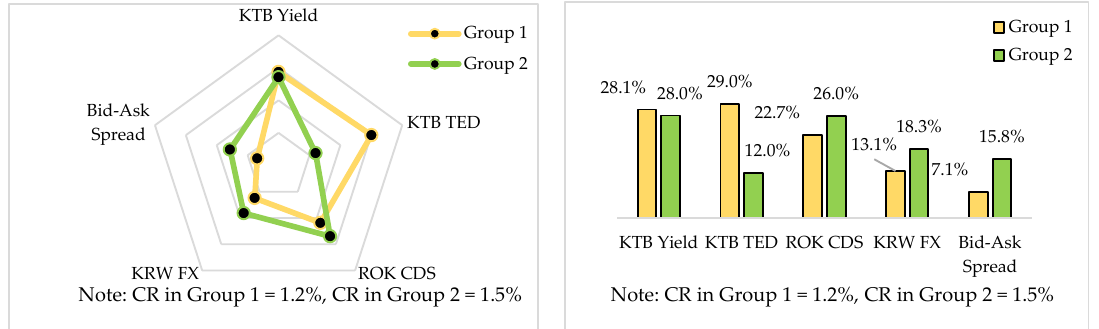
Figure 9. Local weights for domestic factors between group 1 and group 2.